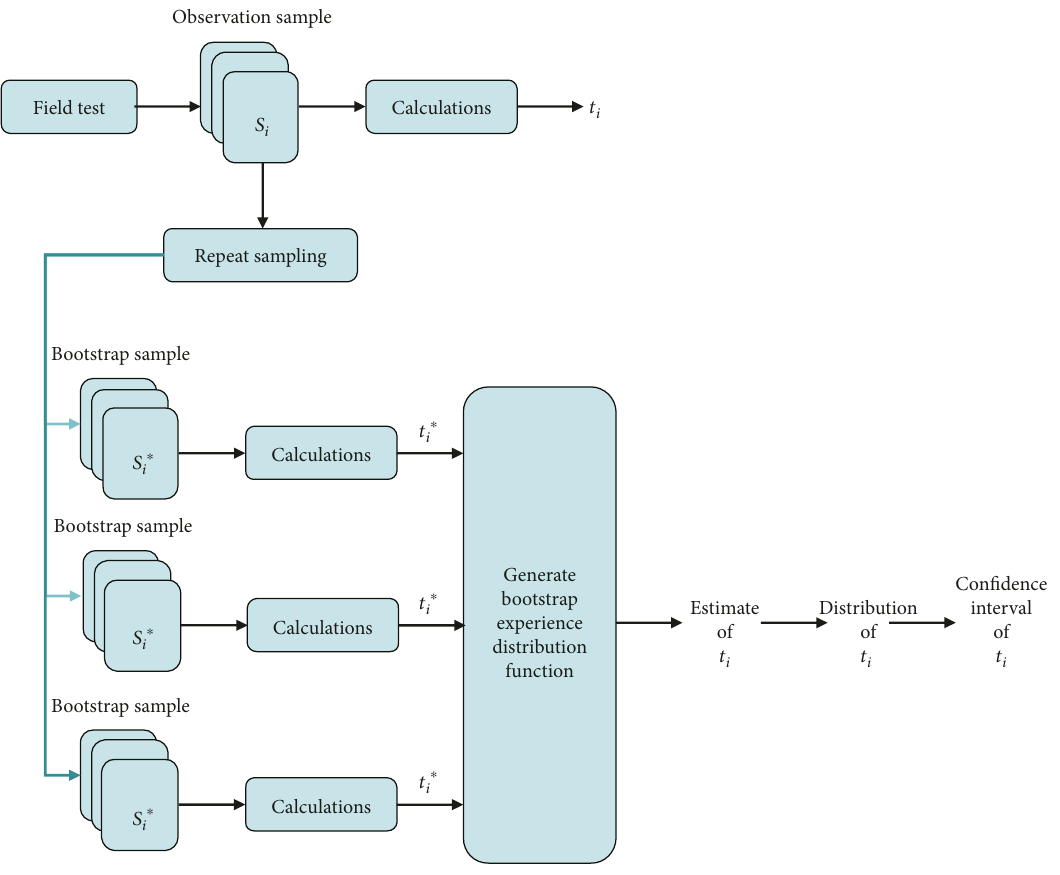
Figure 5: Bootstrap algorithm fl ow.